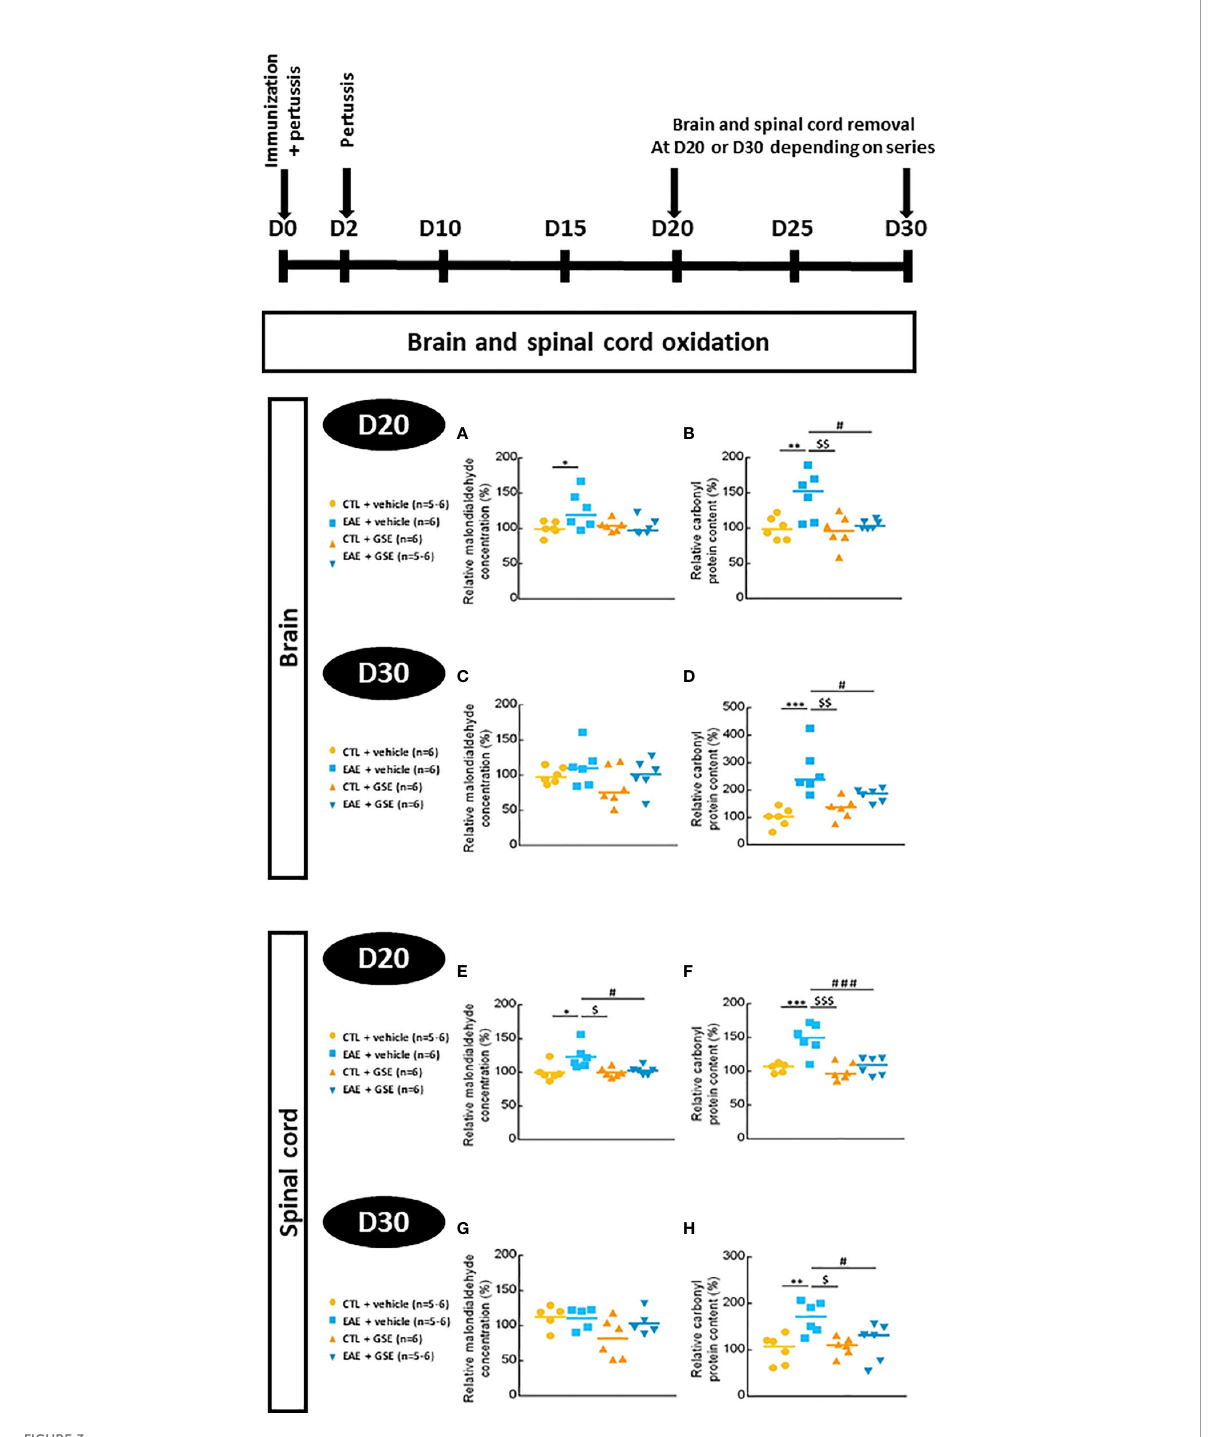
FIGURE 3 Level of lipid and protein oxidation in the brain and spinal cord of experimental autoimmune encephalomyelitis mice (EAE) and their controls (CTL) after curative treatment with grape seed extract (GSE) or vehicle. The lipid peroxidation level was measured by the estimation of relative malondialdehyde concentration compared to CTL + vehicle group, in the brain (A, C) and the spinal cord (E, G) at D20 (A, E) or D30 (C, G) post-induction. Oxidative damage to proteins was evaluated by quantifying the relative carbonyl protein content compared to CTL + vehicle group, in the brain (B, D) and the spinal cord (F, H) at D20 (B, F) or D30 (D, H) post-induction. Statistical analysis was performed using one-way ANOVA followed by Tukey ’ s multiple comparison test: *p < 0.05, **p < 0.01, ***p < 0.001 EAE + vehicle vs CTL + vehicle; #p < 0.05, ###p < 0.001 EAE + GSE vs EAE + vehicle and $p < 0.05, $$p < 0.01, $$$p < 0.001 EAE + vehicle vs CTL +